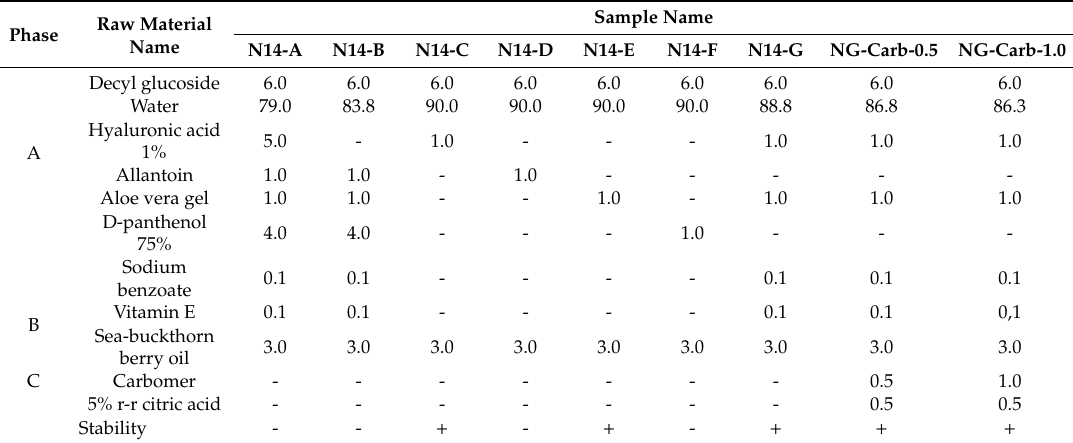
Table 2. The qualitative and quantitative composition of the emulsions enriched with other ingredients. Phase